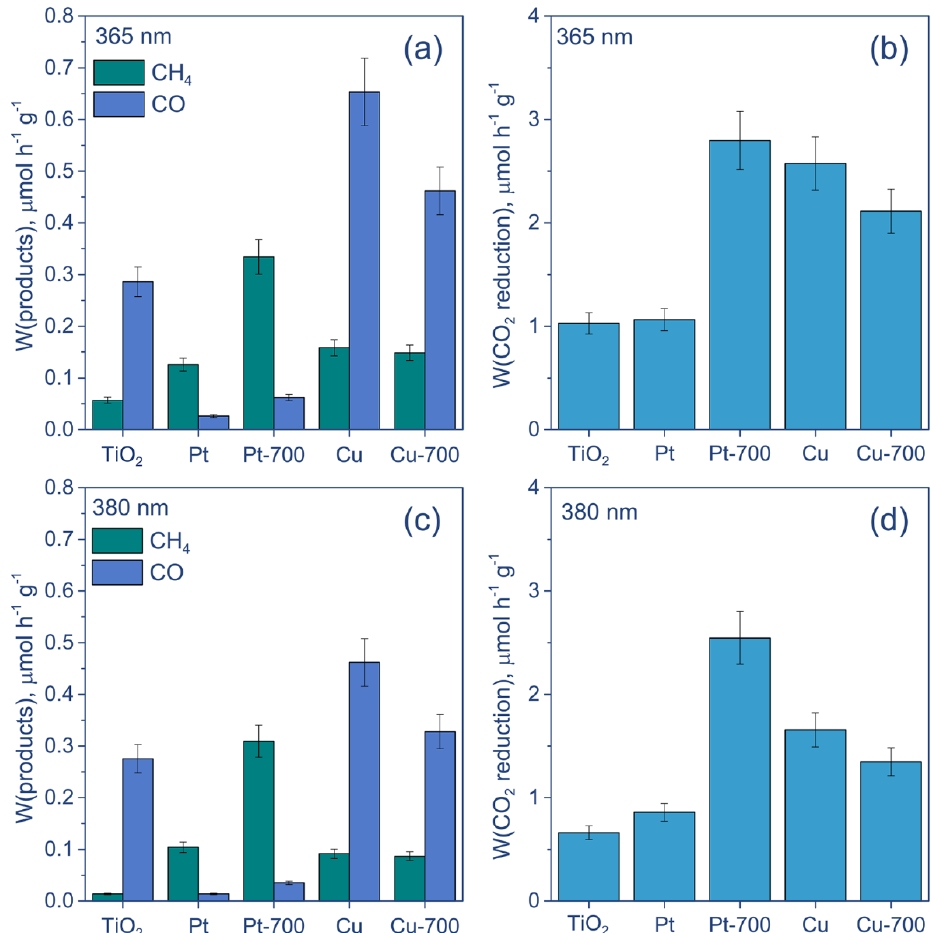
Figure 3. The results of activity study of photocatalytic reduction of CO 2 under irradiation by light of ( a , b ) LED-365 nm and ( c , d ) LED-380 nm. Conditions: m(cat.) = 30 mg, P 0 (CO 2 ) = 1 atm, t = 24 h. Designation: “Pt” and “Cu” means Pt/TiO 2 and Cu/TiO 2 , respectively; “Pt-700” and “Cu-700” means Pt/TiO 2 700 and Cu/TiO 2 700, respectively.